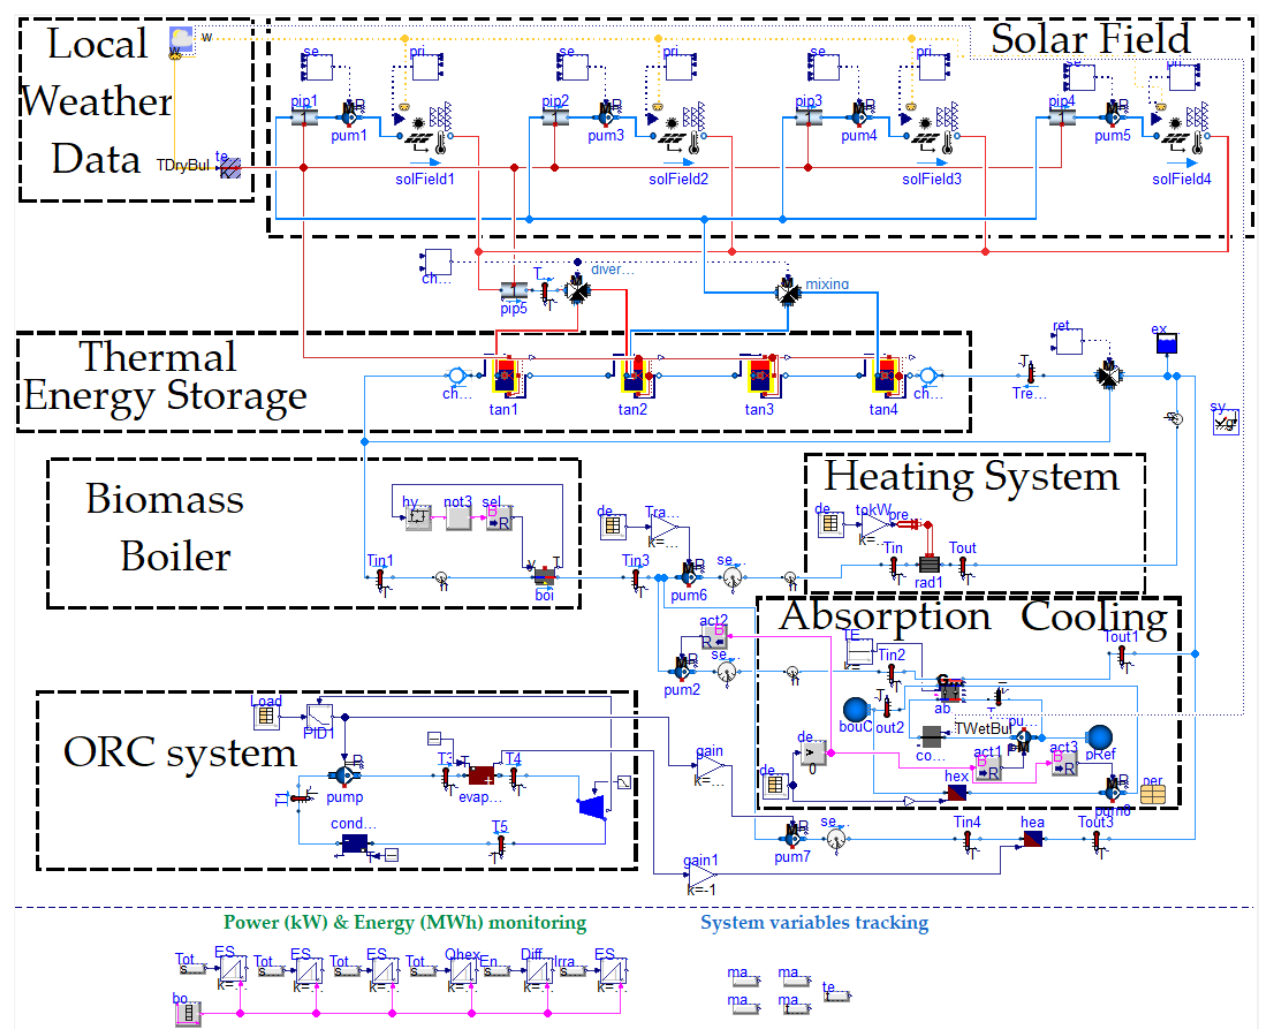
Figure 10. Local thermal grid model.